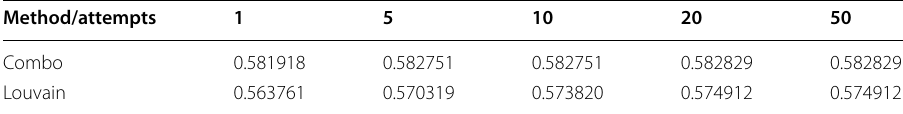
Table 1 The best modularity scores reached by the Combo and Louvain method after a different number of attempts for the Email